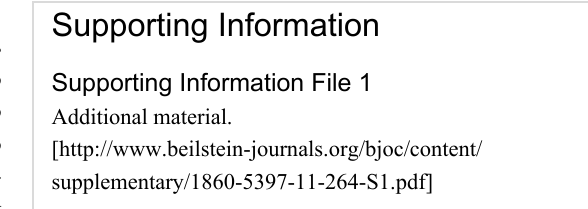
enantiomeric excess during the course of the reaction.